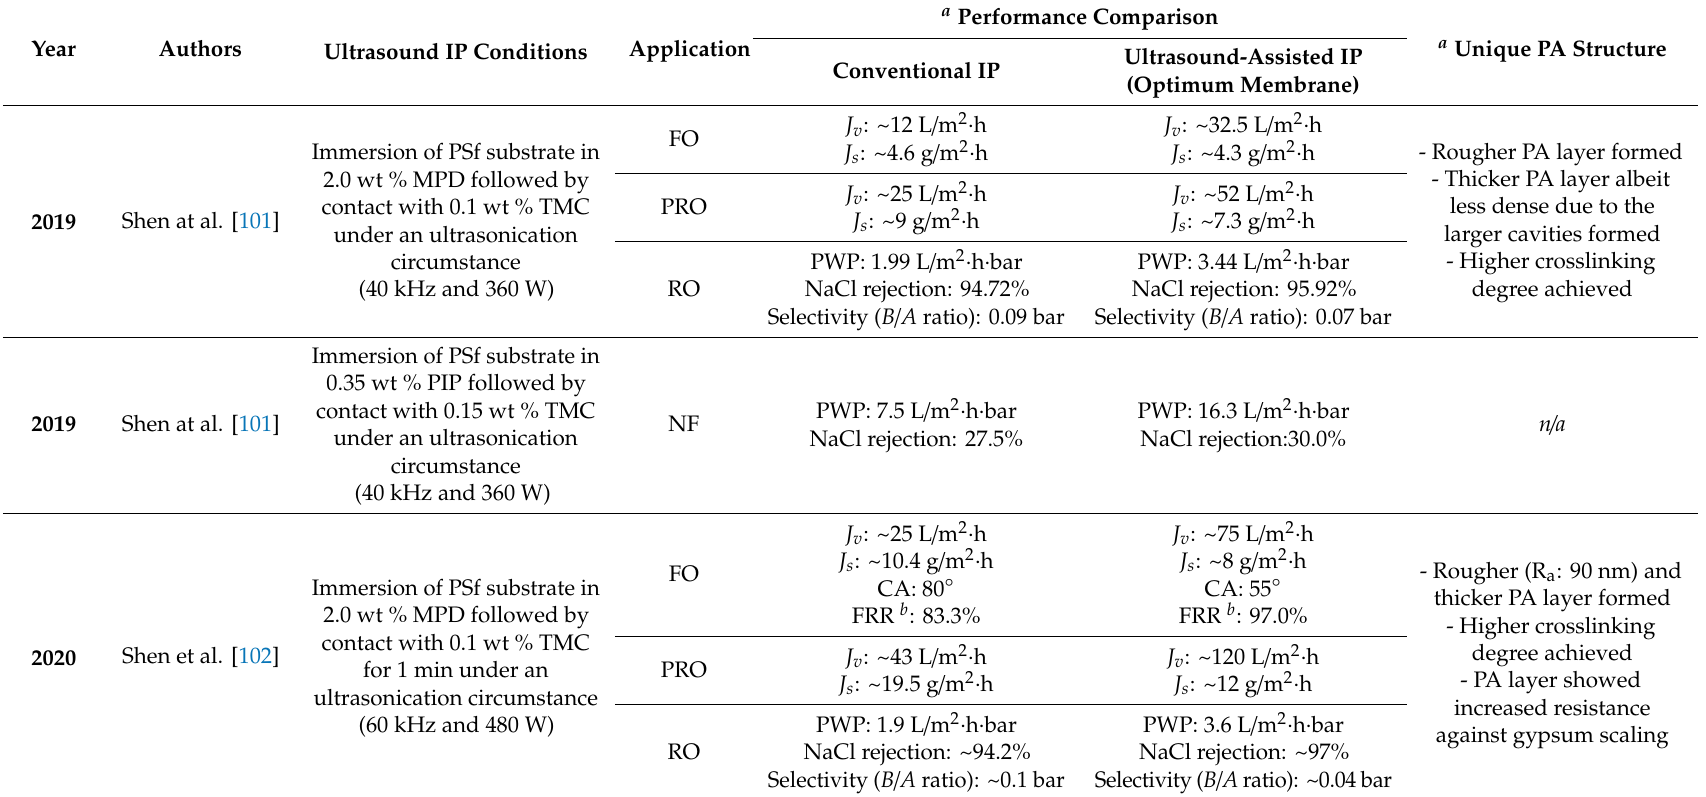
Table 4. Comparison of TFC membranes fabricated by using conventional and ultrasound-assisted